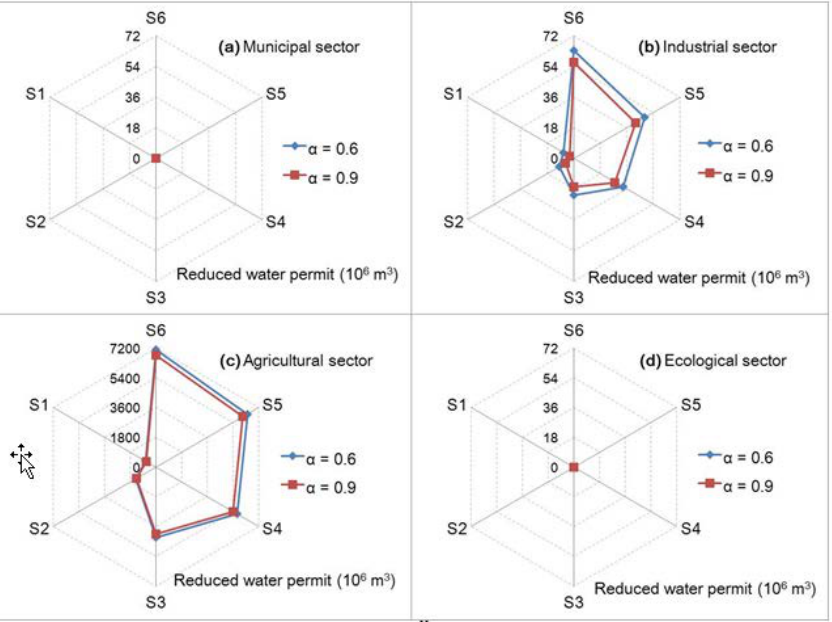
Figure 5. Reduced water rights among the municipal, industrial, agricultural and ecological sectors. (figure ( a ) represents reduced water right in municipal sector; figure ( b ) represents reduced water right in industrial sector; figure ( c ) represents reduced water right in agricultural sector; figure ( d ) represents reduced water right in ecological